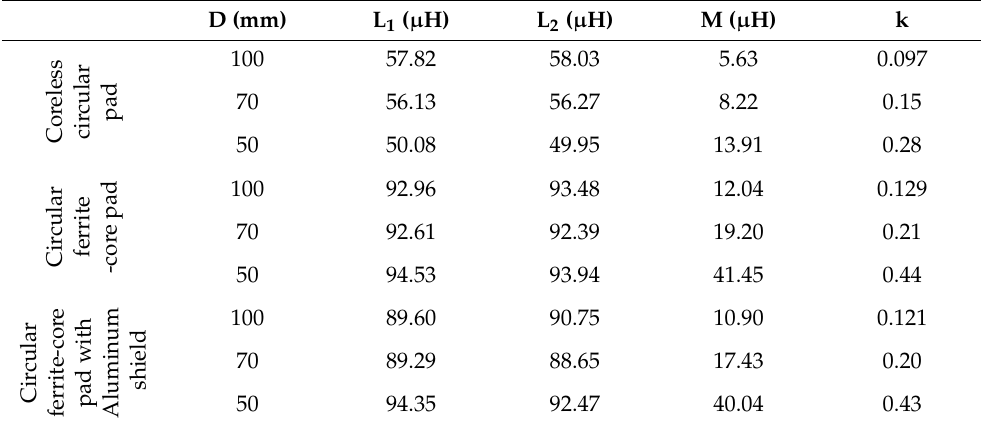
Table 4. Circular pad simulation outcomes